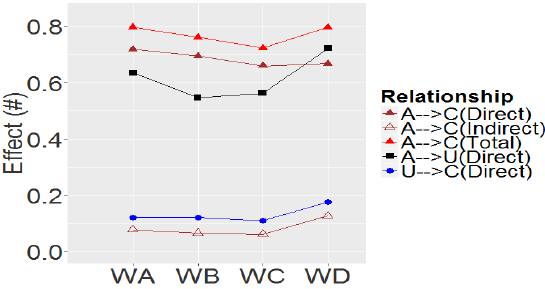
Fig. 5c. Direct, indirect and total effect for the female